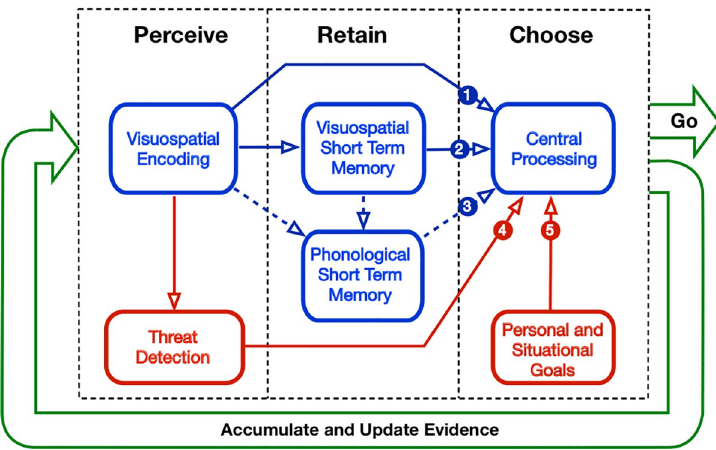
Fig 4. The Perceive, Retain, Choose (PRC) model has been developed as a new model of dynamic risky decision making. The role of short-term memory is explicitly emphasised, with possible processing pathways which inform a driver’s decision about when to pull out of a junction or make other risky dynamic